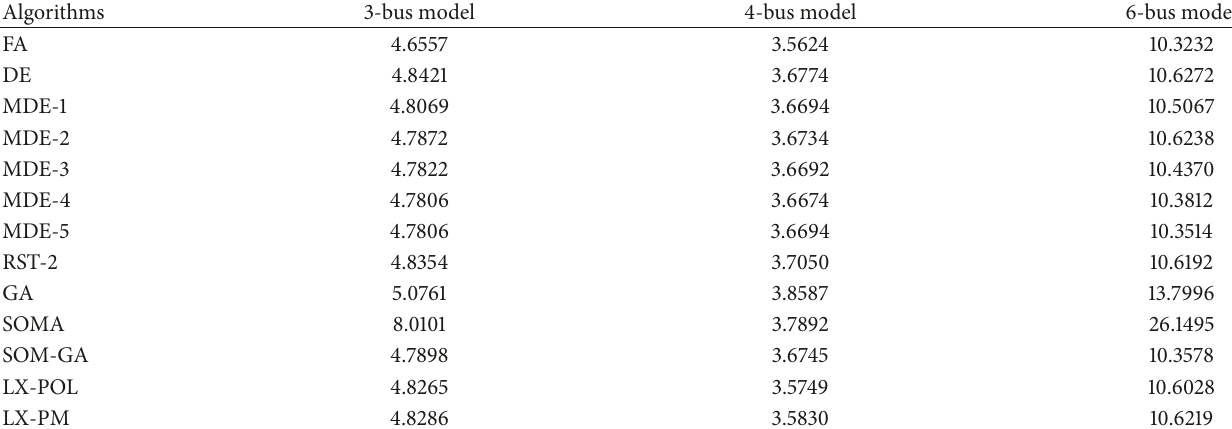
Table 5: Comparison of the best values obtained for IEEE (3-, 4-, and 6-bus) systems.